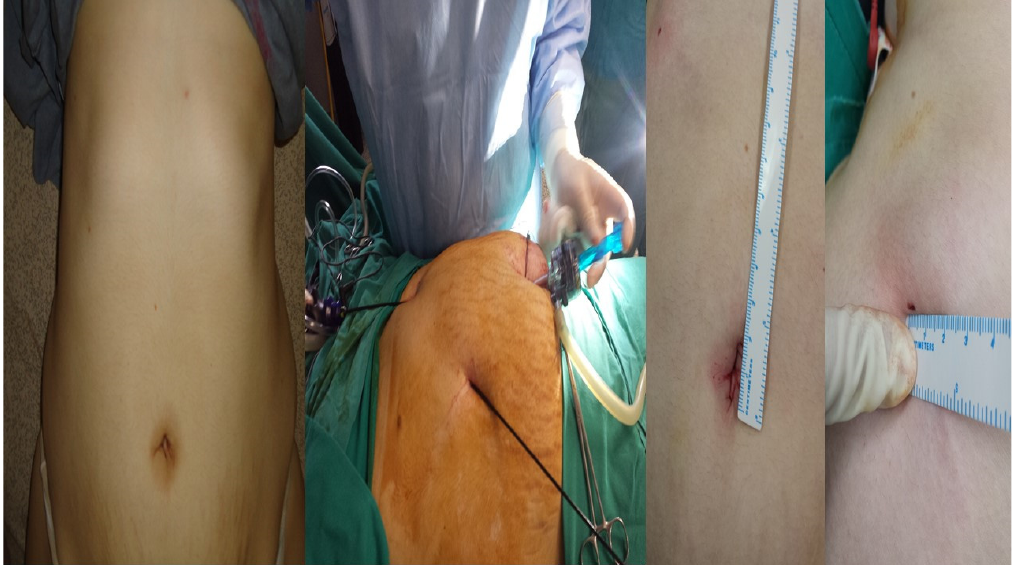
Figure 1. From left to right. The patient before surgery, trocars and equipment placement during surgery, traumatic postsurgery holes from the equipment. A total of 1 bipolar and 19 retrograde cholecystectomies were performed. Table 1. Tools used.